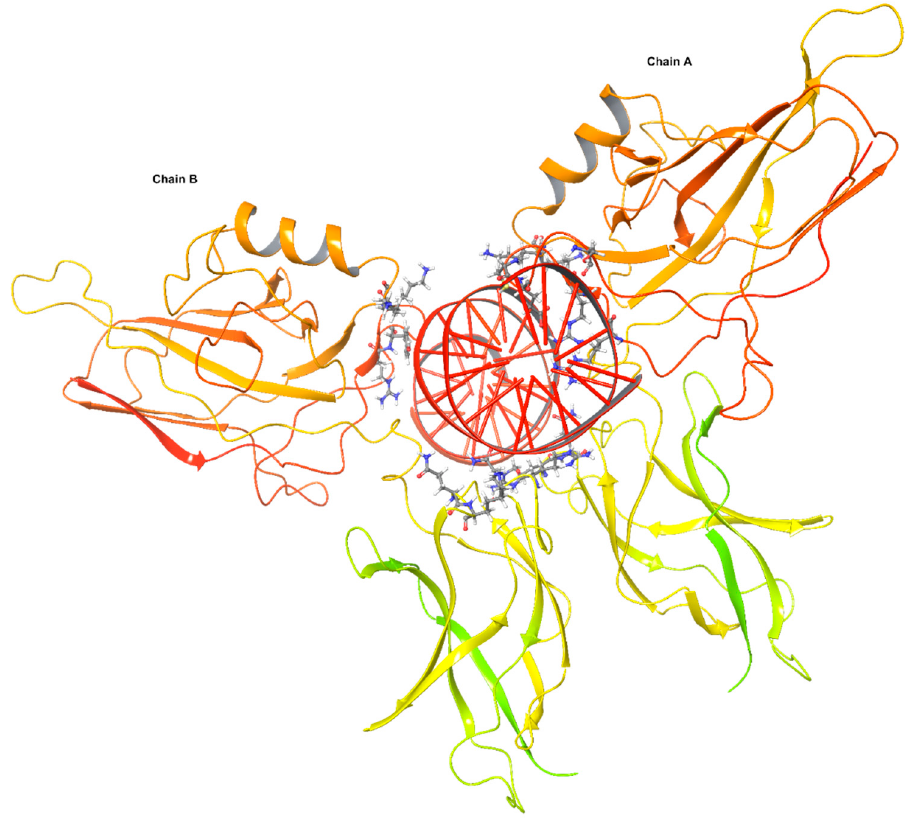
Figure 3. The crystal structure of the NF-kB p65 (PDB ID 2RAM) homodimer in complex with DNA. In colored ribbons the p65 subunits, in the red ribbon the DNA helix, in sticks are reported the residues that form H-bonds with the DNA helix.